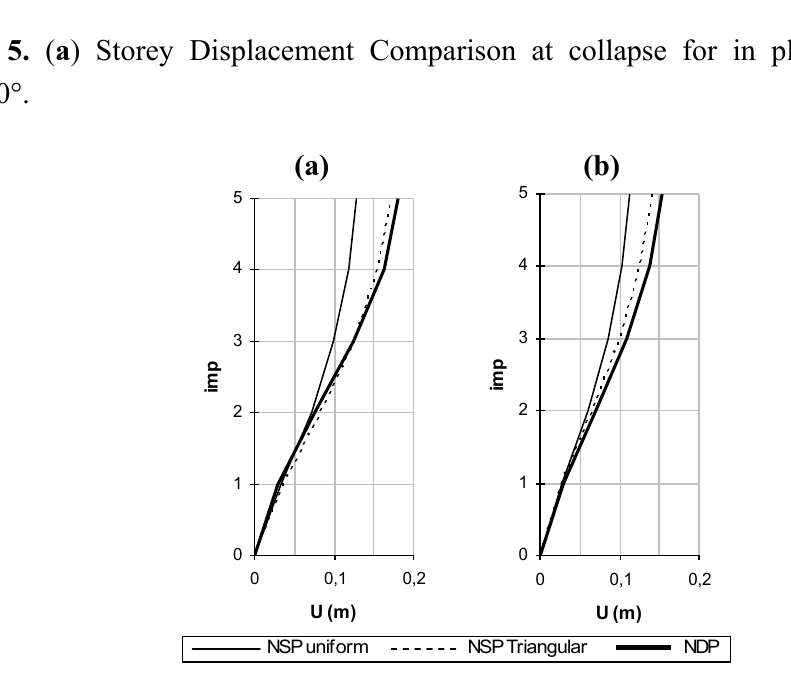
Figure 6. Comparison between Incremental Dynamical Analysis and static non linear analyses-In plan orientation of benchmark structure 0°.